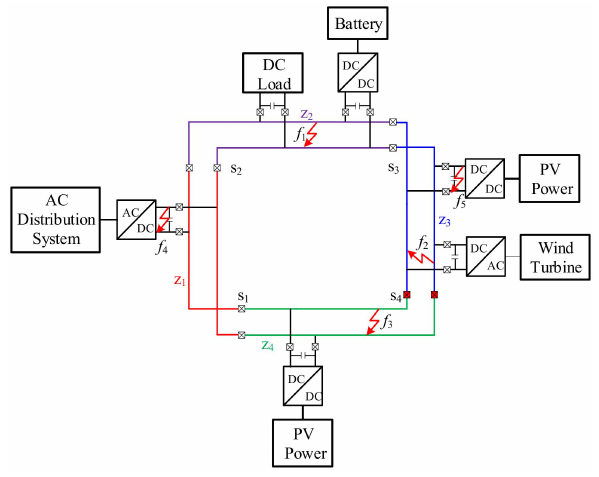
Figure 8. Simulation system.